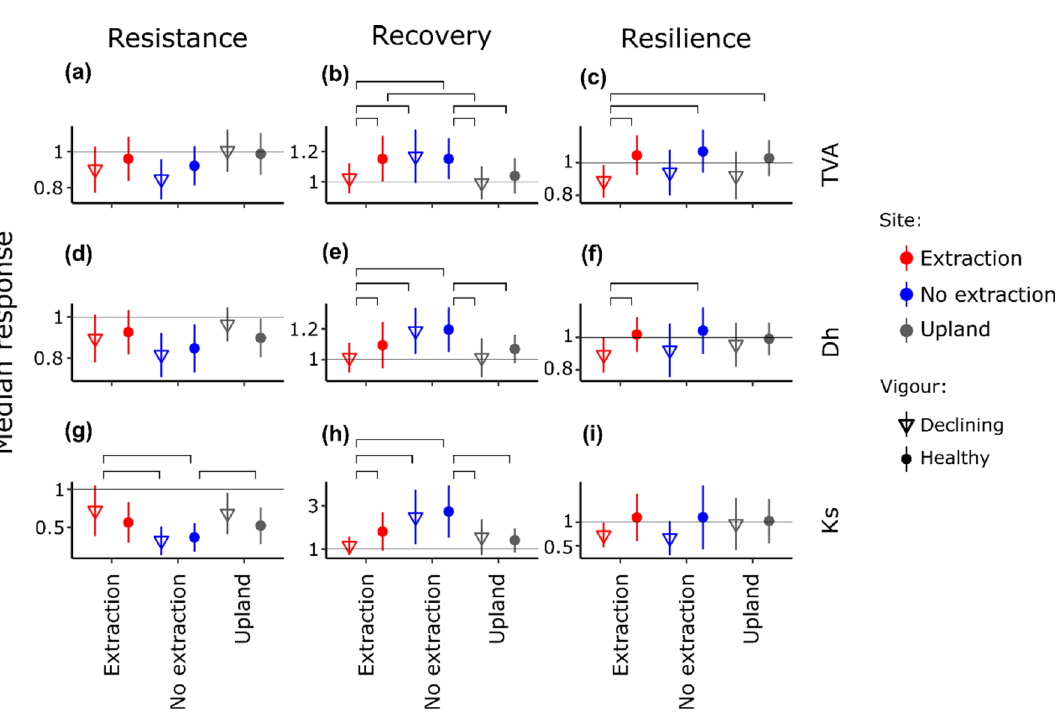
Figure 7. Median components of resilience (resistance: ( a ), ( d ) and ( g ); recovery: ( b ), ( e ) and ( h ); and resilience: ( c ), ( f ) and ( i )) for vessel related variables (total vessel area (TVA); hydraulic diameter (Dh); and hydraulic conductivity (Ks)) of trees at different sites (red for extraction, blue for no extraction and grey for upland sites). Points denote healthy trees and triangles declining trees. Bars denote median absolute deviation. Brackets connect statistically significant different groups ( p <